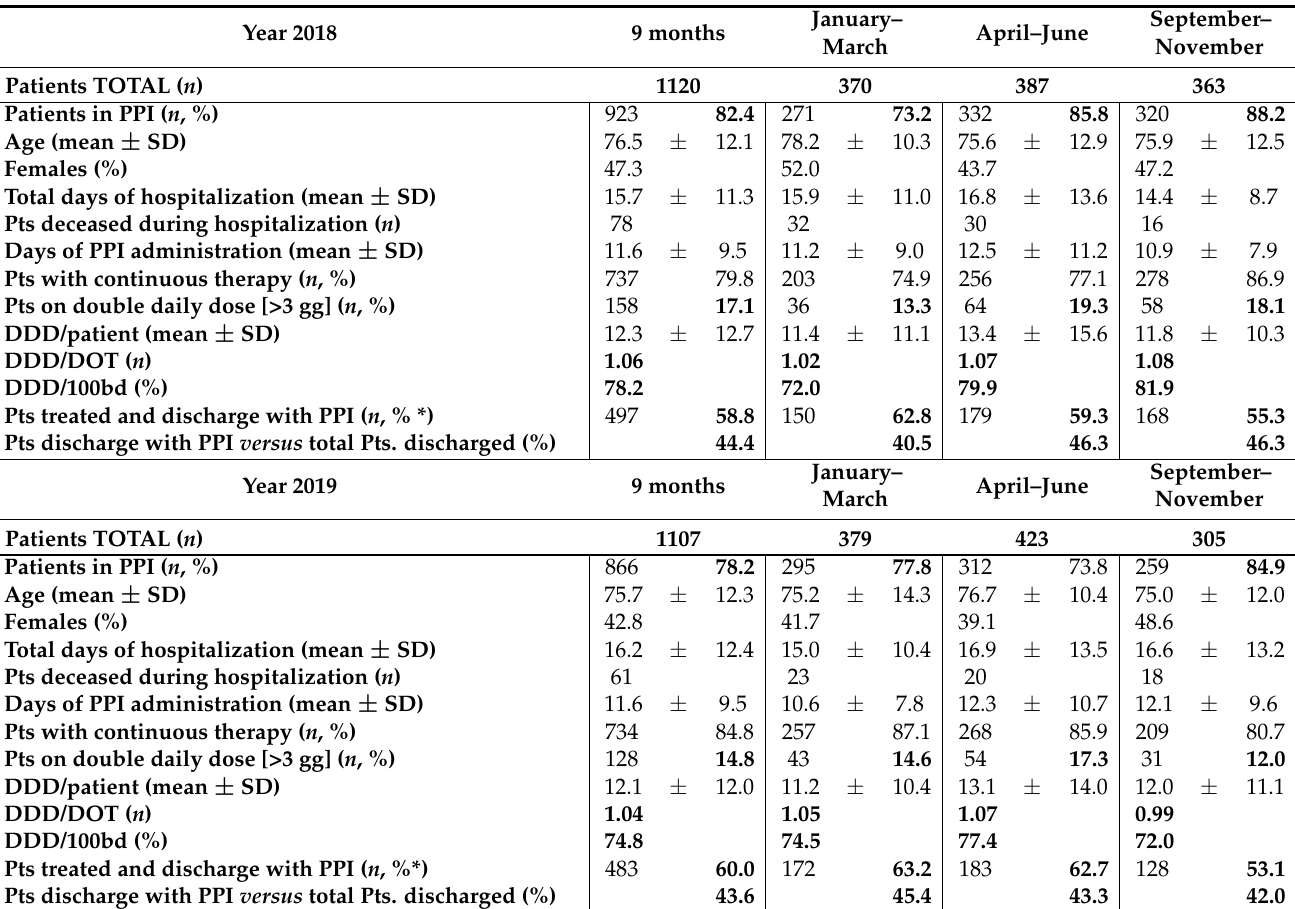
Table 1. Data of Patients treated with